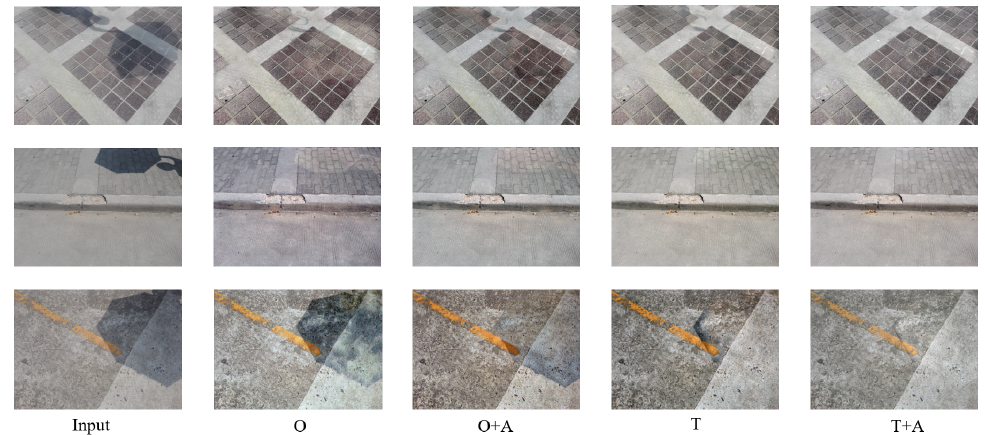
Figure 8. Visualization results of each variant of our method. From left to right: Input, O (one encoder-decoder without attention mechanism), T (two encoder-decoder nets without attention mechanism), O+A (one encoder decoder with attention mechanism) and T+A (the whole network, two encoder-decoder nets with attention